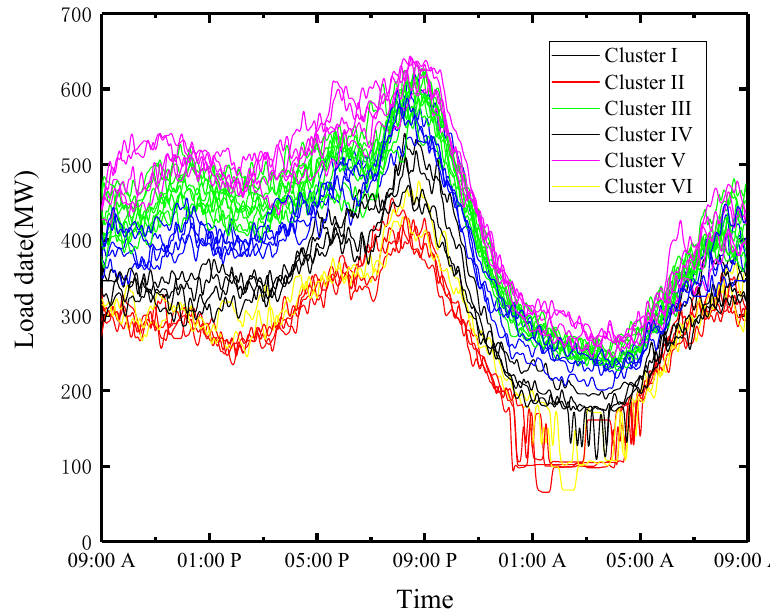
Figure 10. Classification of active daily load curve after cluster analysis.